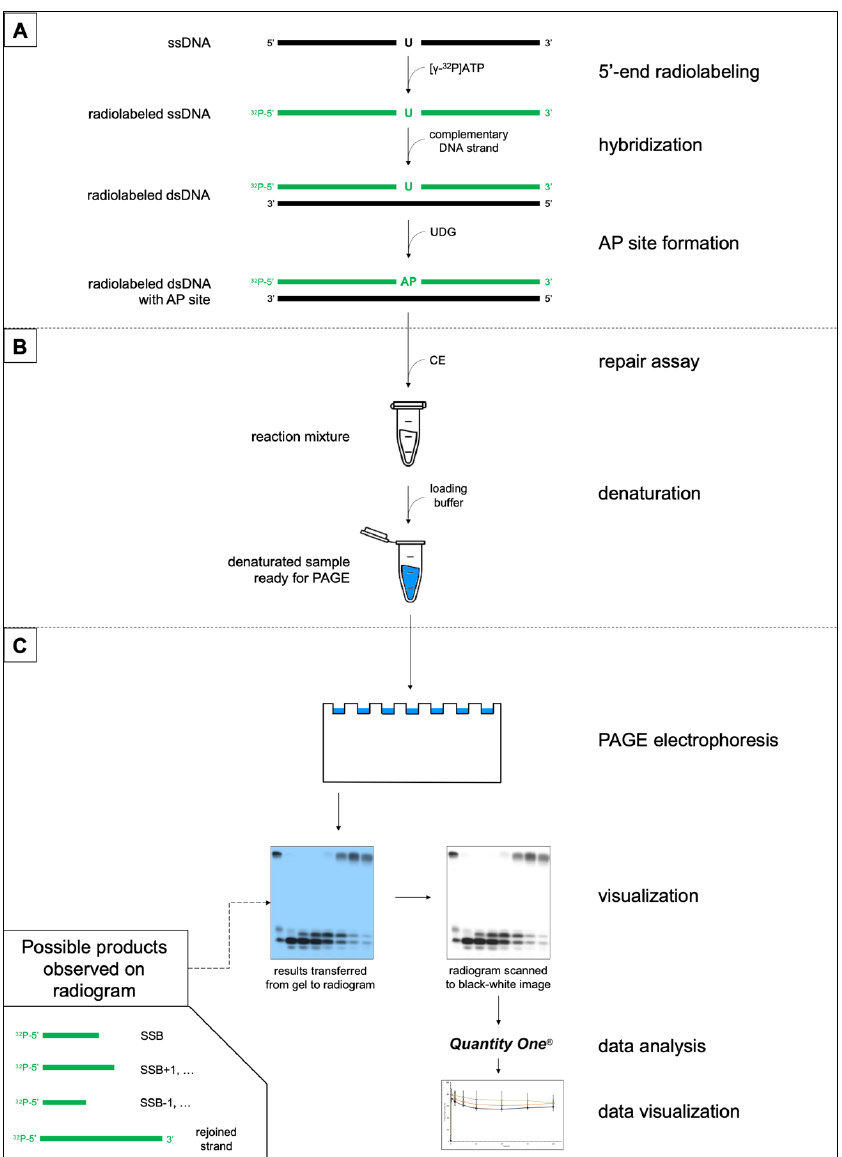
Figure 1. The schematic representation of an experimental procedure used in this study. ( A ) The substrate oligonucleotides’ preparation (see Section 2.1). U represents the position of a 2′ -deoxyuridine (dU), which served as a precursor of an apurinic/apyrimidinic site (AP site); AP represents the position of an AP site within the strand that was obtained from dU after treatment with uracil DNA-glycosylase (UDG); green color represents a radiolabeled strand of ds-oligonucleotide (40 bp). ( B ) The repair assay experiment (see Section 2.4). Reactions were conducted in 37 ◦ C for 0, 1, 5, 15, 30, 60, 90, and 120 min. The 50 µ g of cytoplasmic extracts (CE) was used (see Section 2.3). ( C ) The visualization of obtained results by PAGE, autoradiography, and data analysis. SSB—single-strand break, reaction product obtained after AP site cleavage resulting from the endonucleolytic activity of CE; SSB+1, . . . —reaction products obtained after adding 1 or more nucleotides to the cleaved strand resulting from polymerase activity of CE; SSB − 1, . . . —reaction products obtained after removal of 1 or more nucleotides from the cleaved strand resulting from the exonucleolytic activity of CE; and rejoined strand—reaction products obtained after reaching full repair of DNA